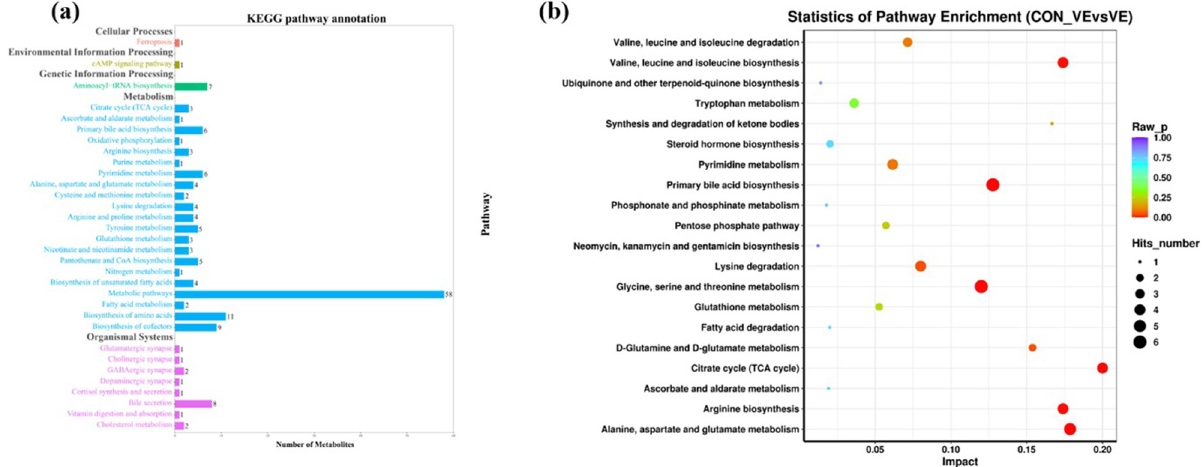
Fig 6. KEGG pathway annotation and enrichment analysis of metabolites in yak serum before and after VE injection. (a) The KEGG pathway annotation analysis of metabolism pathway. The horizontal axis is the number of differential metabolites, and the vertical axis is the pathway. Different colors represent different secondary-level of pathways classification in the system. (b) The enrichment analysis of top 20 metabolism pathways. The color and size of each circle is based on P -values and pathway impact values respectively.